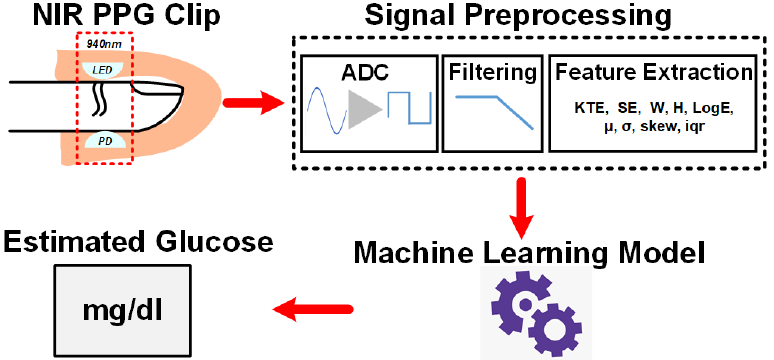
Figure 6. Block diagram of the NIR PPG signal glucose sensing platform with machine learning.